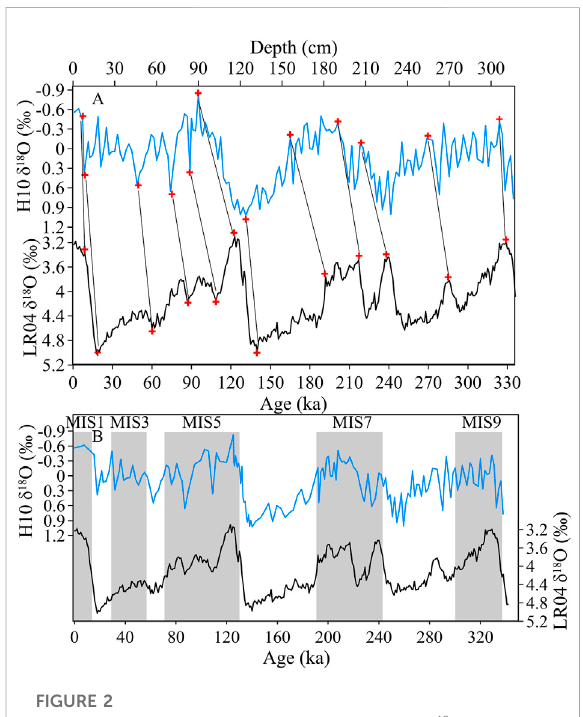
FIGURE 2 (A) Age control points (red cross symbol) of H10 δ 18 O (comparedwithLR04Stack δ 18 Ocurve,LisieckiandRaymo,2005); and (B) age results.